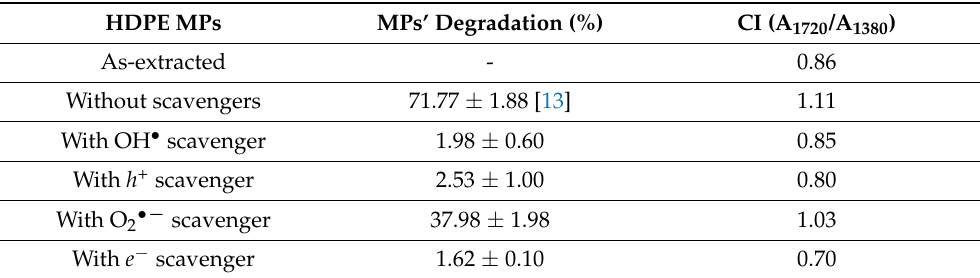
Table 3. Comparison of the CI of the as-extracted HDPE MPs with those subjected to visible-light photocatalytic degradation by C,N-TiO 2 in the presence of scavengers. HDPE